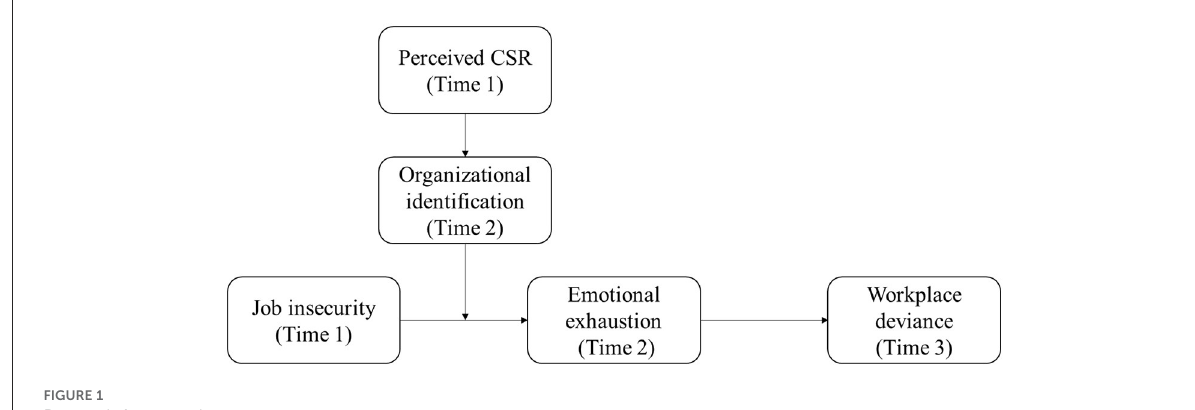
FIGURE1 Research